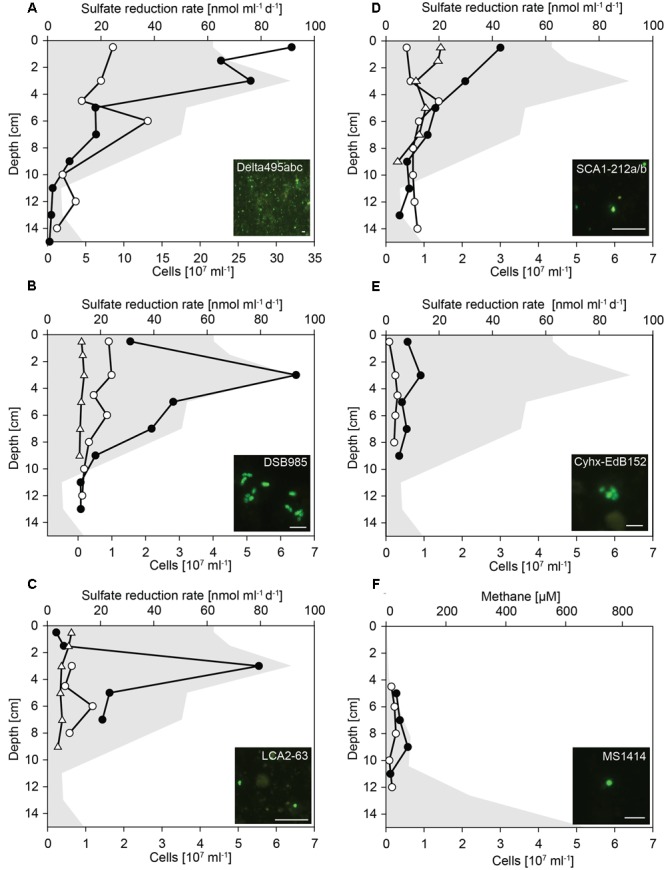
Cell numbers of Deltaproteobacteria and hydrocarbon-degrading SRB in untreated and SOFT sediments. Vertical profiles show specific cell numbers in untreated (white dots) and SOFT (black circles) core sediments as detected by CARD-FISH with (A) probe Delta495abc for Deltaproteobacteria, (B) probe DSB985 for Desulfobacula spp., Desulfotignum spp., and Desulfobacter spp., (C) probe LCA2-63 for clade LCA2, (D) probe SCA1-212a/b for clade SCA1, (E) probes Cyhx-EdB_152/152b for clade Cyhx, and (F) probe MS1414 for Methanosarcina spp., Methanococcoides spp., Methanolobus spp., and Methanohalophilus spp. As reference, cell numbers detected with probes SCA1-212a/b, DSB985, and LCA2-63 were determined in the untreated-3 years core that was stored for 3 years at 0°C in the dark (white triangles). Sulfate reduction rates (A–E) and methane concentration (F) in SOFT core sediments are visualized by gray area (data taken from Mishra et al., this issue). Bar = 5 μm.